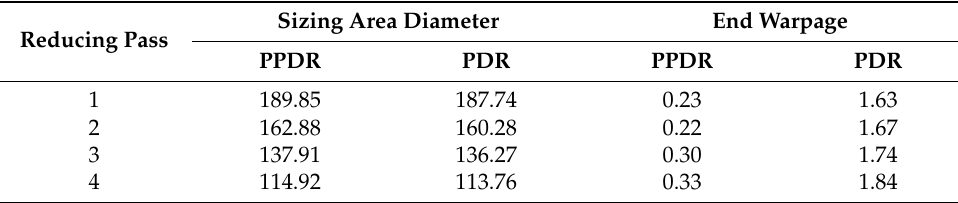
Table 7. Comparison of warpage and diameter (mm).